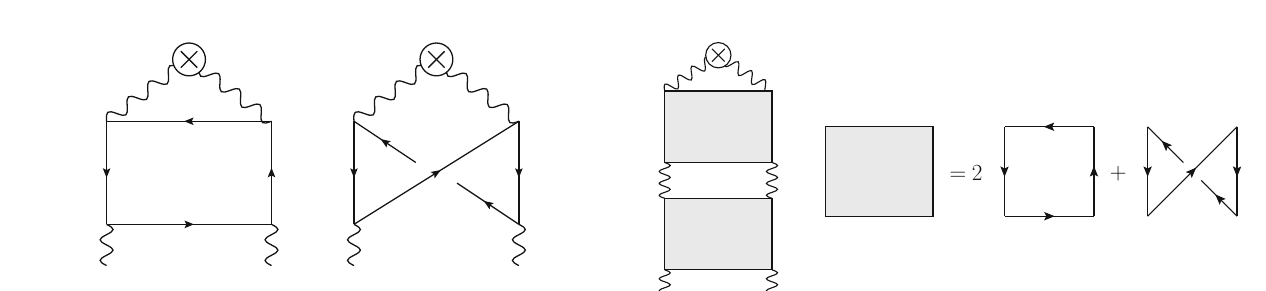
Fig. 3 The LO diagrams contributing to the anomalous dimension γ − .